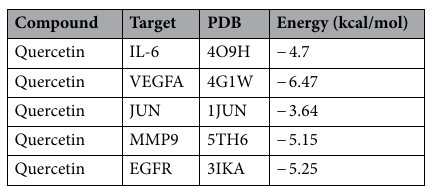
Table 3. Molecular docking results.